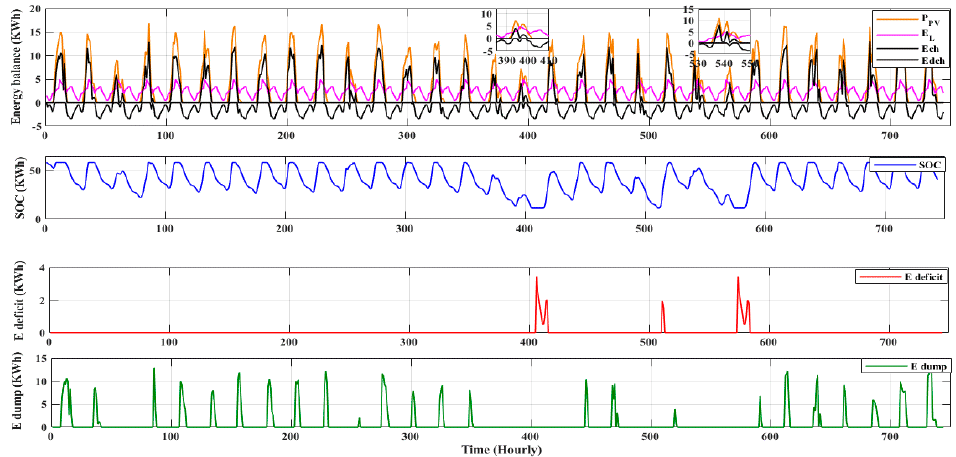
Figure 15. Performance of the SAPV system based on chosen optimal configuration in December.